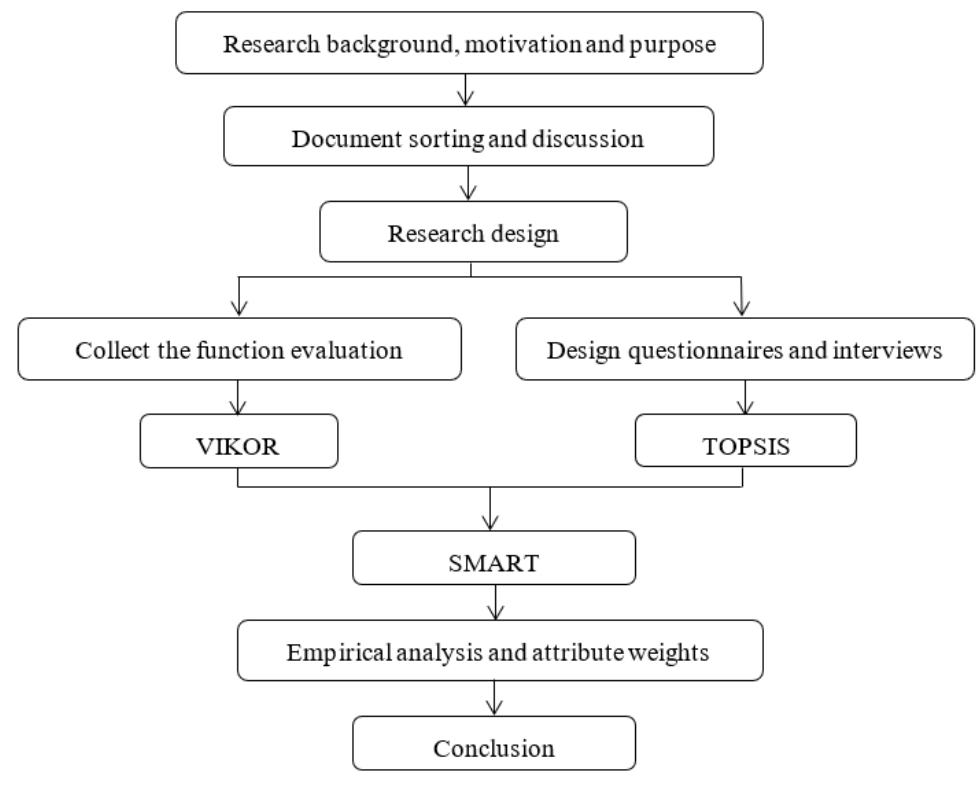
Figure 1. The framework of brand performance analysis.